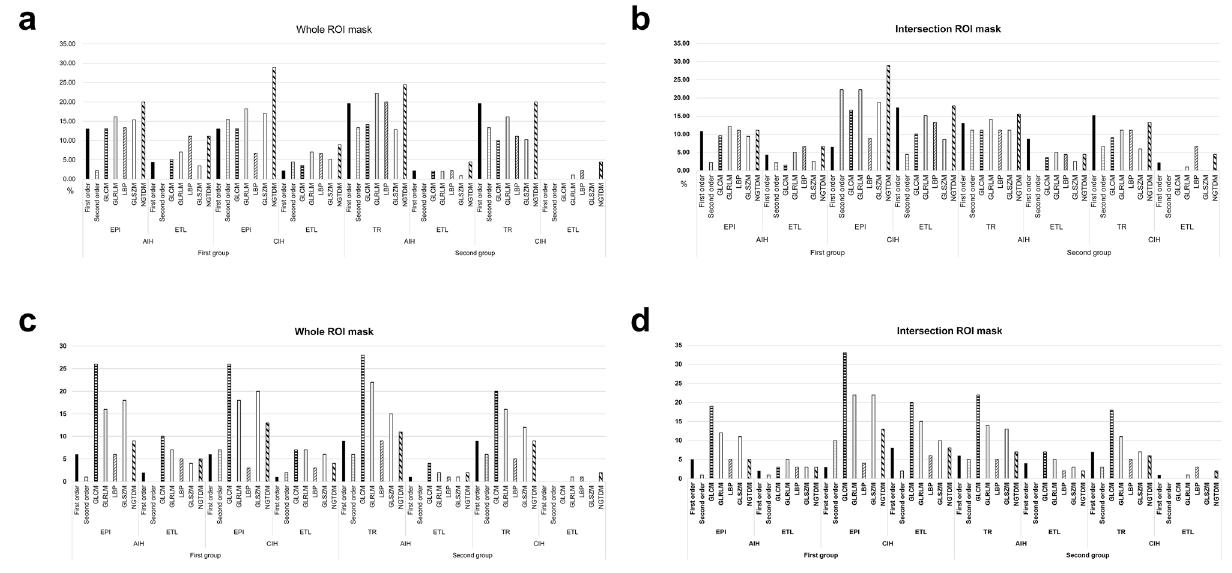
Figure 2. Proportions of stable radiomic features extracted from whole- and intersection ROI masks on each fast scanned T2-FLAIR sequence in the first and second groups. (a,b) Proportions of stable radiomic features from whole ROI masks (a) and intersection ROI masks (b) according to each fast scanned T2-FLAIR. (c,d) Numbers of stable radiomic features from whole ROI masks (c) and intersection ROI masks (d) according to each fast scanned T2-FLAIR. AIH acute ischemic hyperintensity, CIH chronic ischemic hyperintensity, ROI region-of-interest, EPI echo-planar imaging, ETL echo train length, TR repetition time, GLCM gray-level co-occurrence matrix, GLRLM gray-level run-length matrix, LBP local binary pattern, GLSZM gray-level size zone matric, NGTDM neighboring gray tone difference